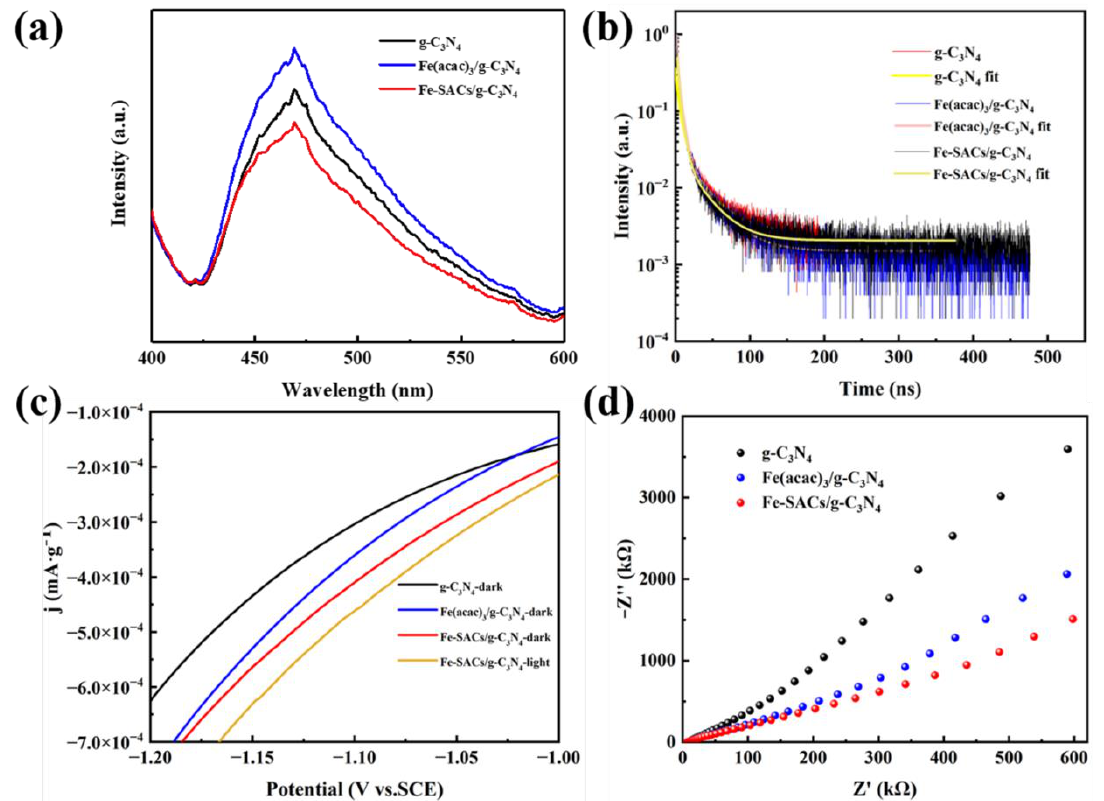
Figure 5. PL spectra of photocatalysts ( a ); Time-resolved photoluminescence decay traces ( b ); LSV curves ( c ); Nyquist plots of EIS ( d ).